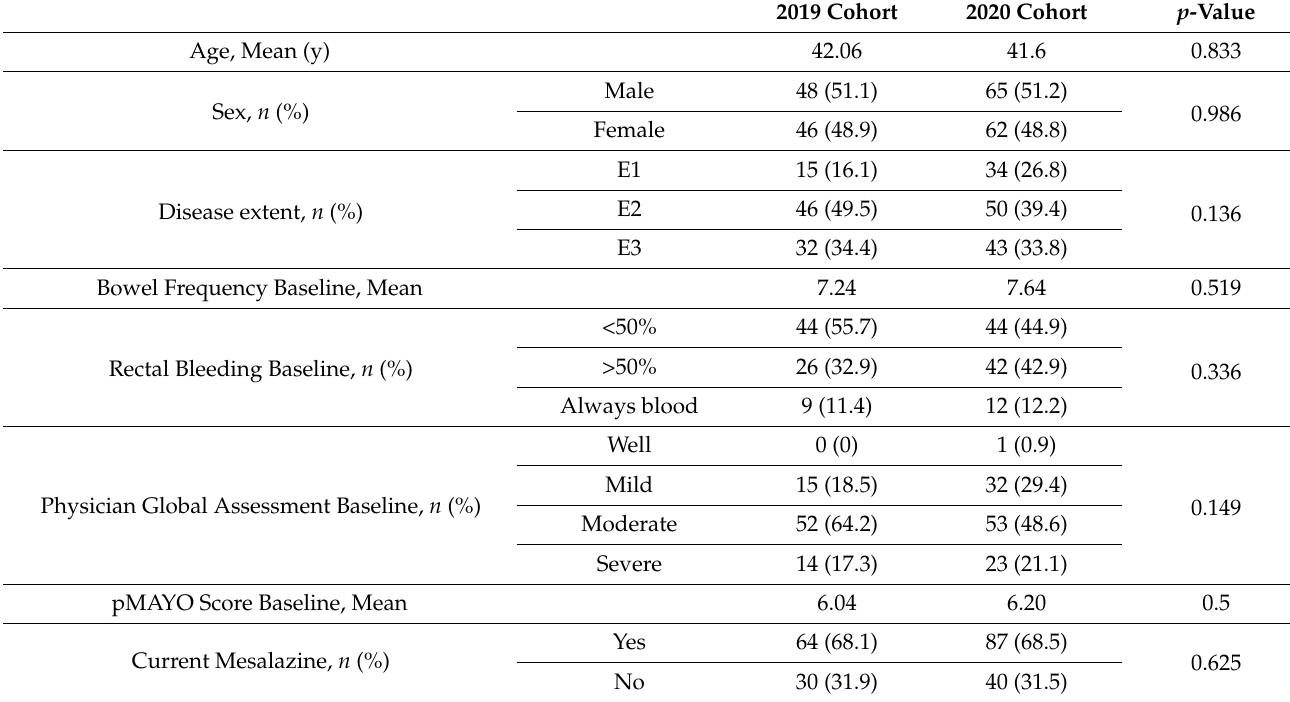
Table 1. Comparison of 2019 and 2020